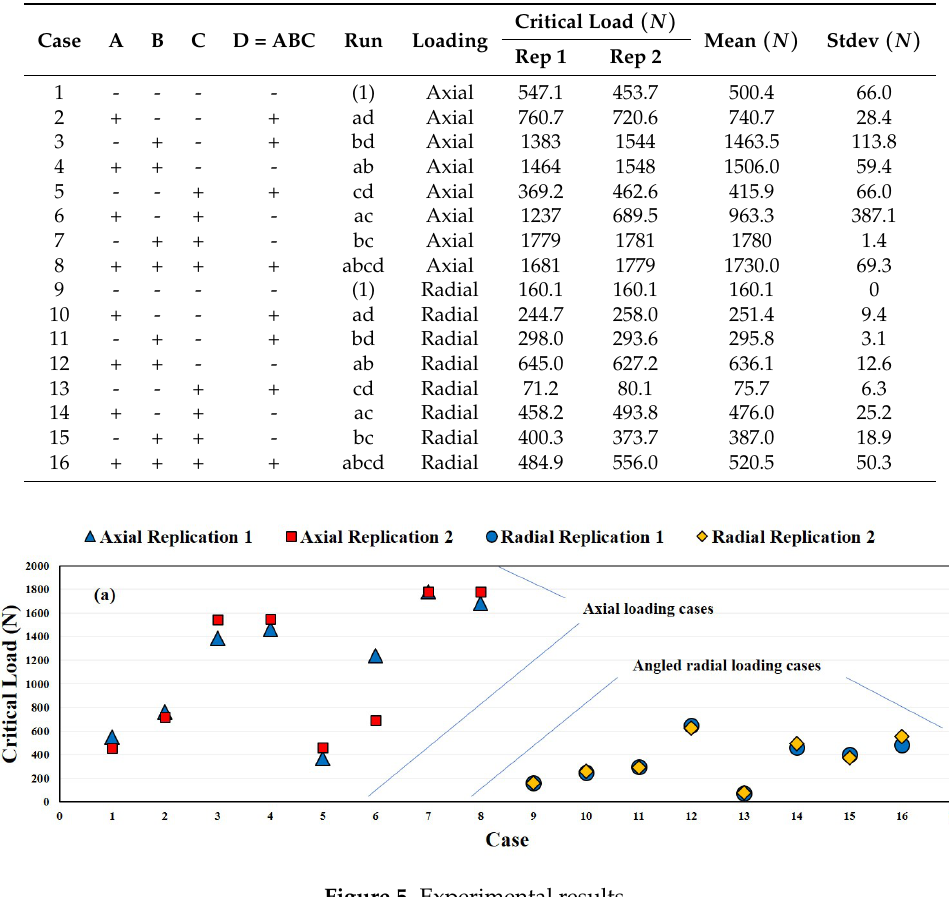
Table 4. 2 ( 4 − 1 ) factorial experimental design and responses.